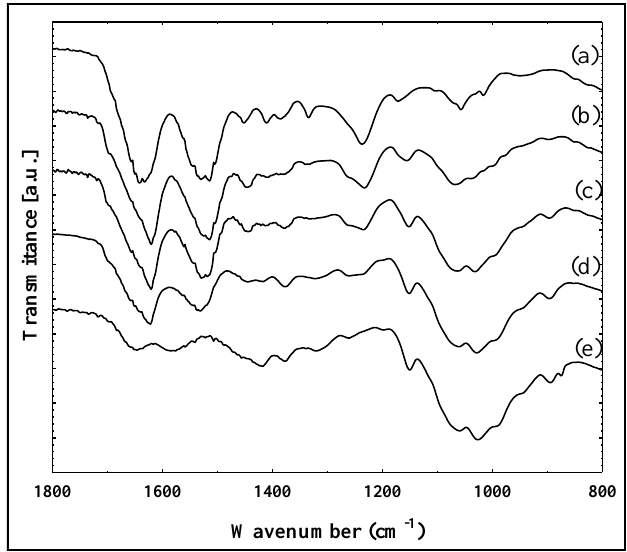
Figure 2. FTIR-ATR spectra of SF/CHI blended films with the ratio SF:CHI of (a) 100:0, (b) 75:25, (c) 50:50, (d) 25:75, (e)